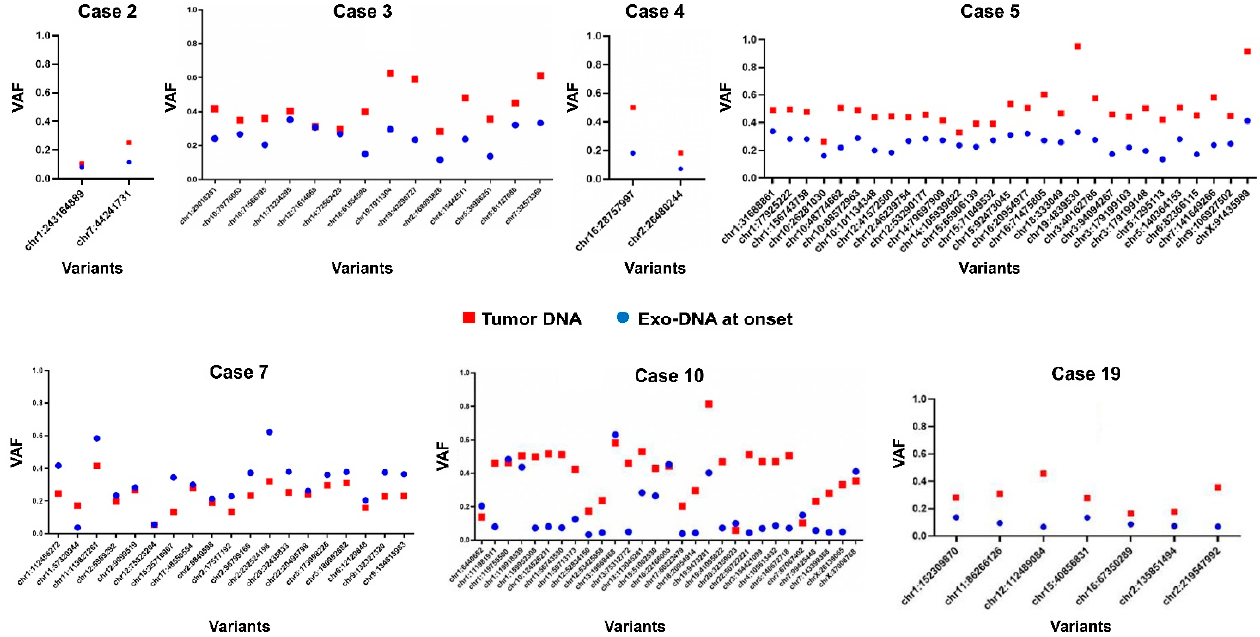
Figure 6. Frequency of the somatic SNVs in common between tumor DNA and exo-DNA at onset (VAF = variant allele frequency).